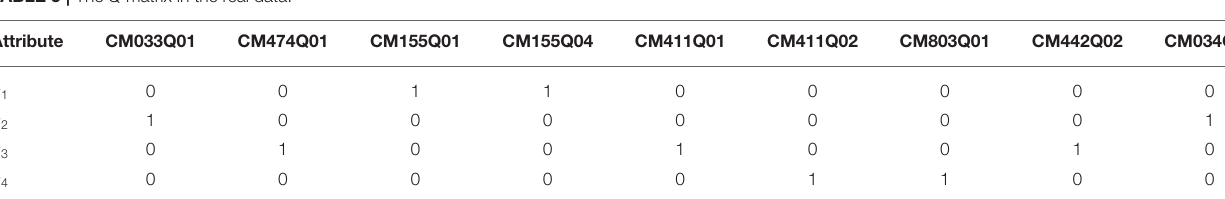
TABLE 5 | The Q matrix in the real data.